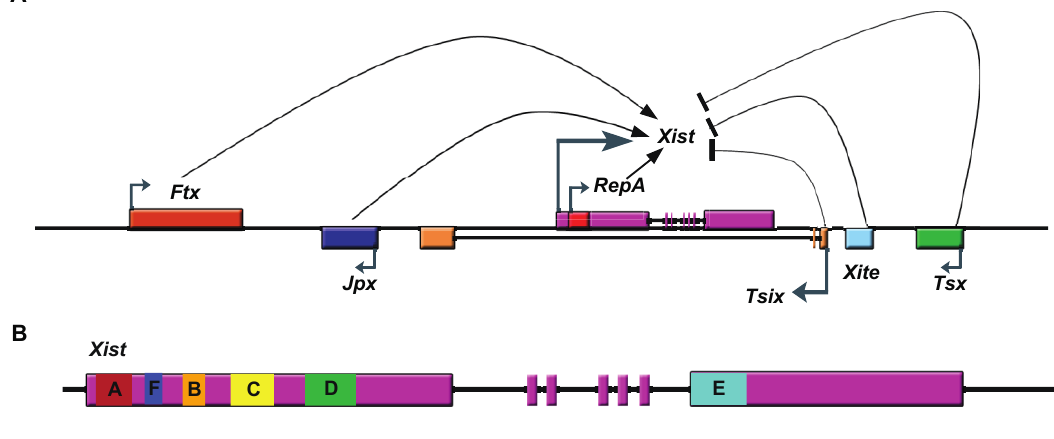
Figure 1. Schematic drawing of the Xic and of Xist . A. lncRNAs transcribed from Xic, a region of the X-chromosome necessary and sufficient to trigger XCI. These lncRNAs include Xist (X-inactivation specific transcript), Tsix (antisense of Xist), Tsx (testis-specific X-linked gene), Xite (X-inactivation intergenic transcription element), RepA RNA, Jpx (also known as Enox (Expressed Neighbor of Xist )), and Ftx (Five prime to Xist ). Ftx , JPX , and RepA lncRNAs promote Xist transcription, while Tsix , Xite and Tsx inhibit it. B. Gene structure of Xist RNA showing location of tandem repeats (A-F). Exons are represented as